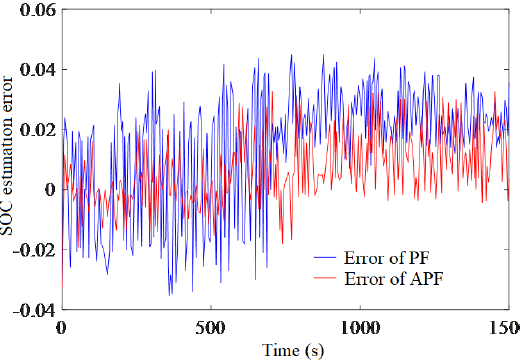
Figure 13. SOC estimation error of PF and APF.